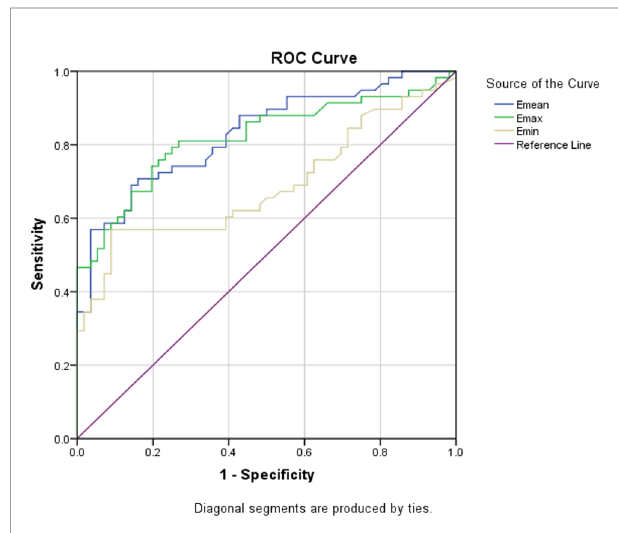
FIGURE 1 | Three ROC curves for the sensitivity and speci fi city of CUE, SWE, and their conjunctive use in ANM diagnosis.